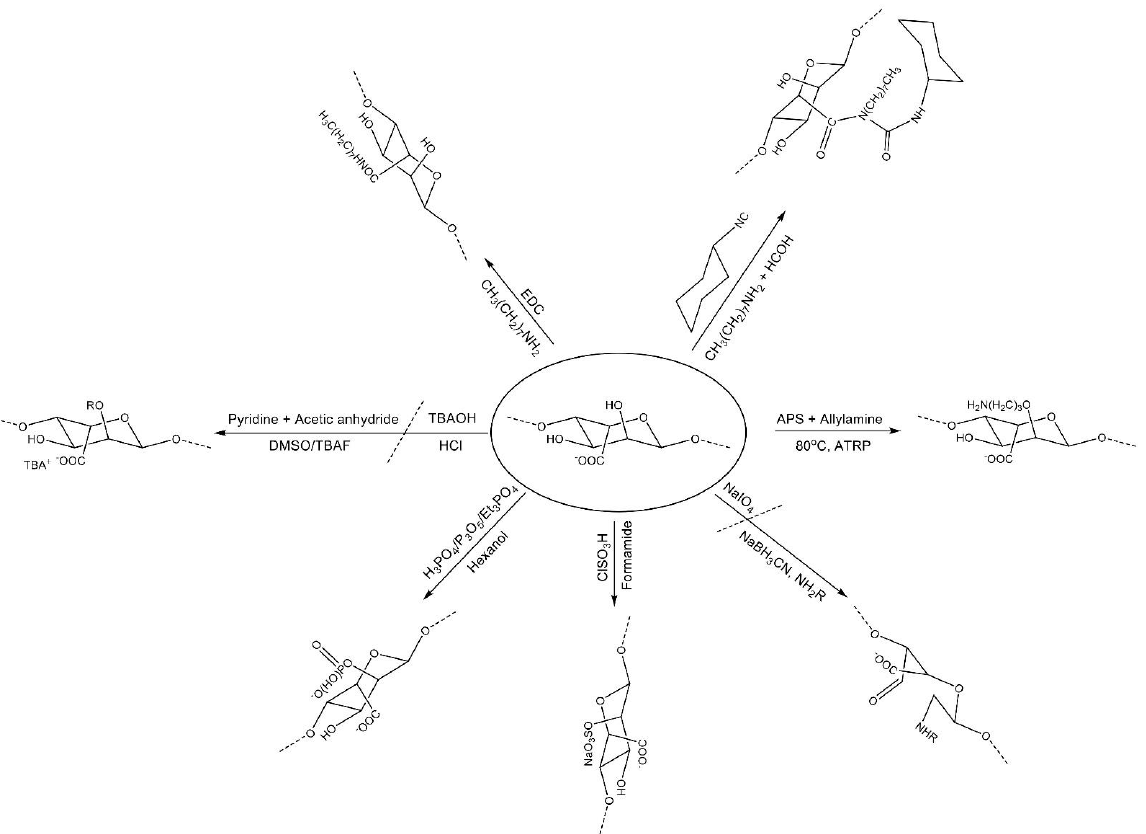
Figure 2. Chemical modification strategies based on the functionalities of alginate.